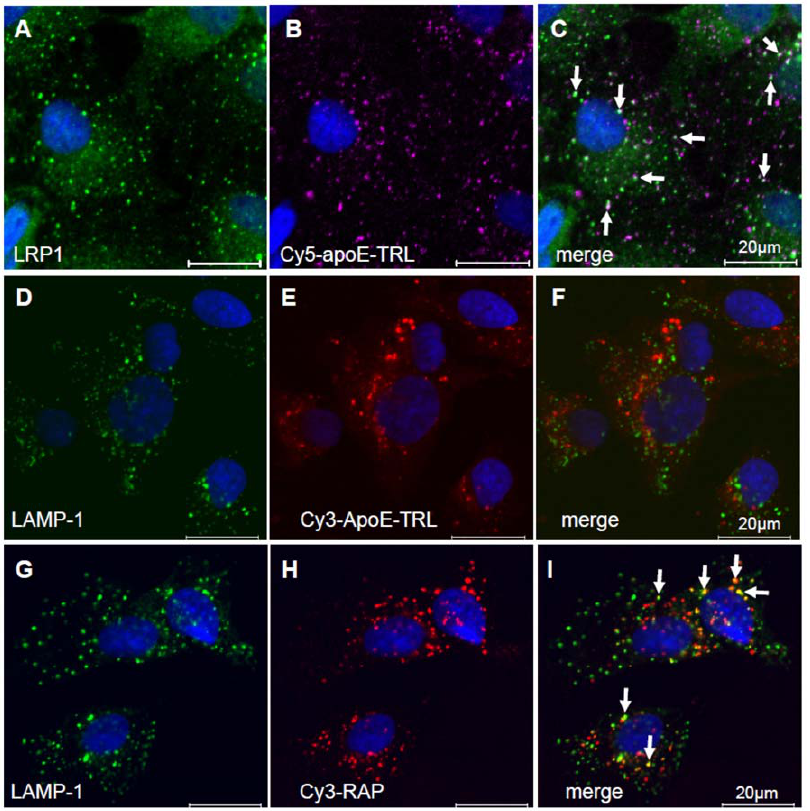
Figure 4. Internalized RAP but not TRL-derived apoE is sorted towards lysosomes. Incubation of HuH7 cells with Cy5-apoE-TRL or Cy3-RAP was performed for 30 min at 37 u C. Subsequent confocal immunofluorescence analysis revealed colocalization of LRP1 with apoE (A–B, see arrows in merged image C). Internalized Cy3-apoE did not appear within lysosomes as indicated by a counterstain with LAMP-1 (D–F). In contrast, after 30 min Cy3-RAP co-localized with LAMP-1 (G–H, see arrows in the merged image I), indicating lysosomal targeting of the LRP1 ligand RAP. Nuclei were visualized by DAPI and appear in blue. Bar is 20 m m.